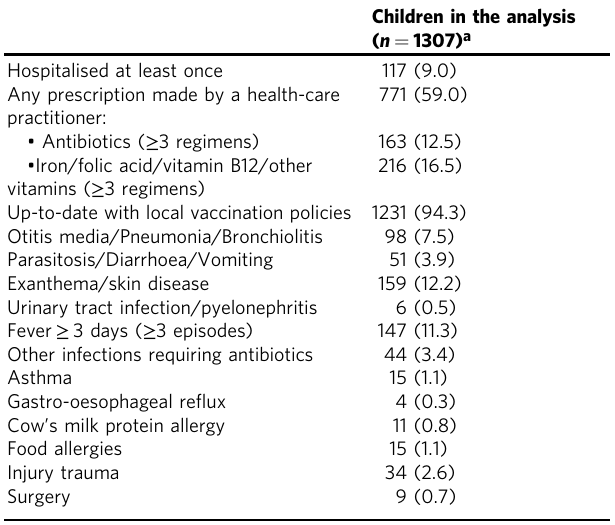
Table 2 Morbidity diagnoses between 1 and 2 years of life of children included in the INTERGROWTH-21 st Neurodevelopment Assessment Study